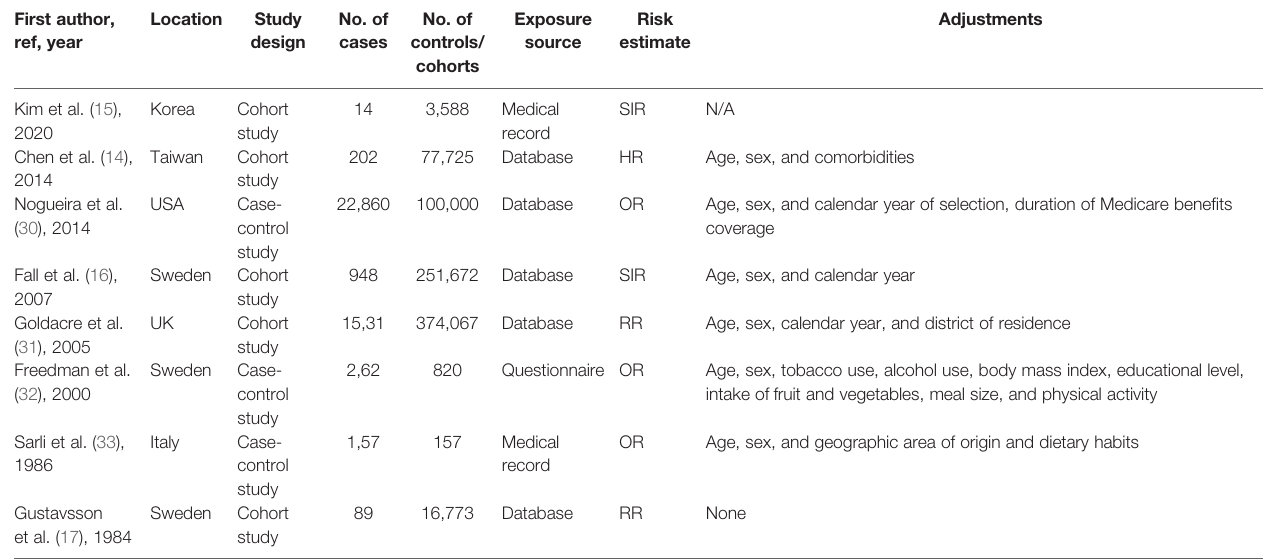
TABLE 1 | Characteristics of studies included in the meta-analysis of the association between cholecystectomy and gastric cancer